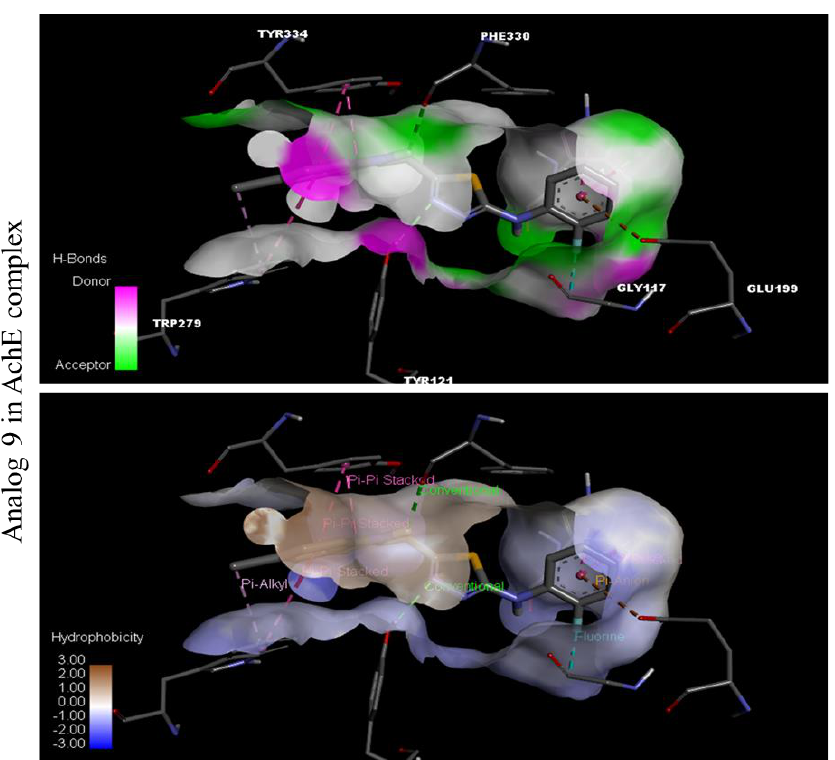
Figure 6. Indication of the hydrogen bond and hydrophobic nature against AChE of compound 9.